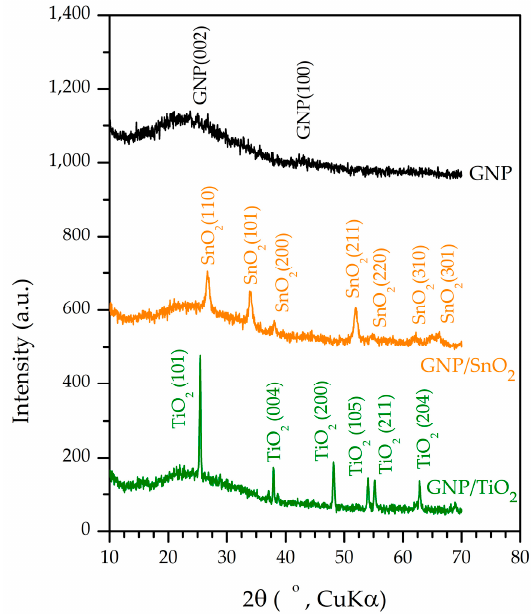
Figure 2. XRD patterns of the carbon-based coatings after the electrochemical degradation at 10 mA/cm 2 for 6